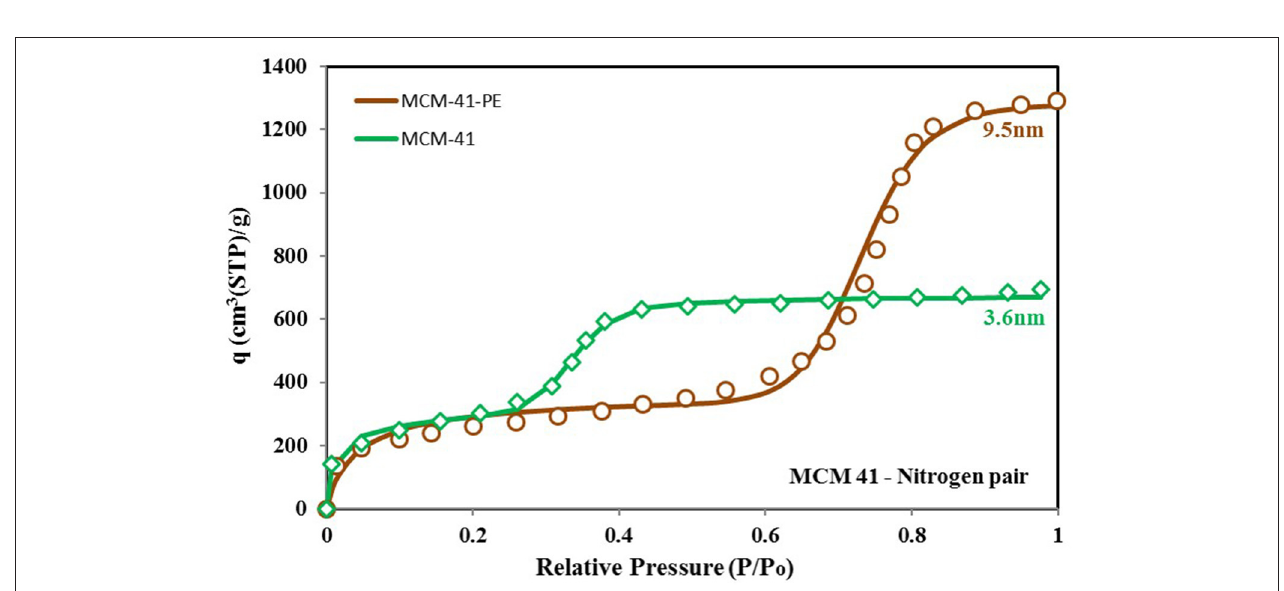
FIGURE 8 | Adsorption sites energy distribution for MCM-41 V1, V2, and V3 variants paired with nitrogen as adsorbate.